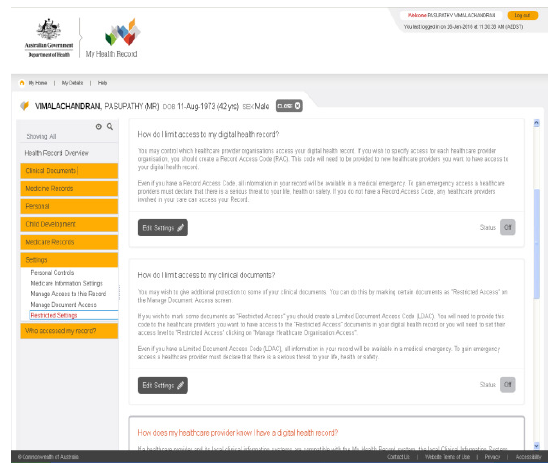
Figure 2: Patient Option to give Restrict